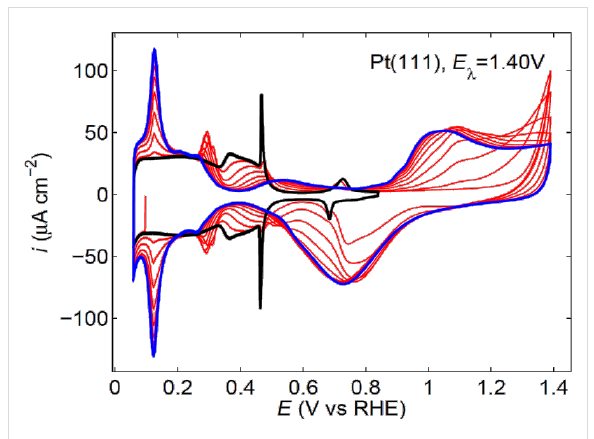
potential is close to 1.2 V and this is a strict upper potential